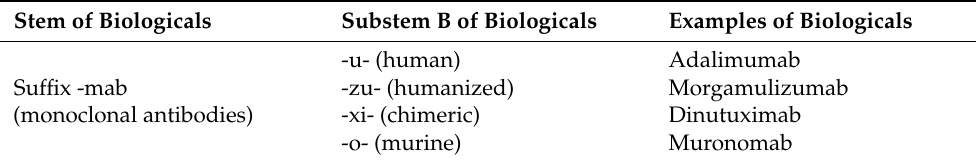
Table 1. Nomenclature of mAb-based biologicals according to the origin of the antibody